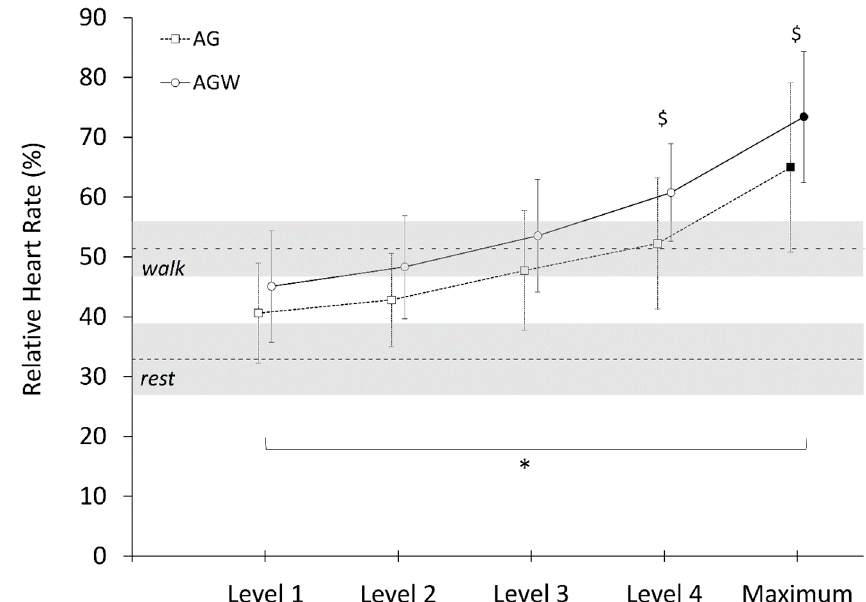
Figure 1. Relative heart rate (%, expressed relative to individual-predicted maximum) across game levels (1–4) and maximum level attained (Maximum) in active gaming with (AG) and without added weights (AG W ). Rest and walk (W6) average values are represented in dashed lines with ± 1 standard deviation (greyed area). Symbol * represents the main significant effect of exercise ( p < 0.001), and symbol $ represents significant differences between AG and AG W ( p < 0.001).